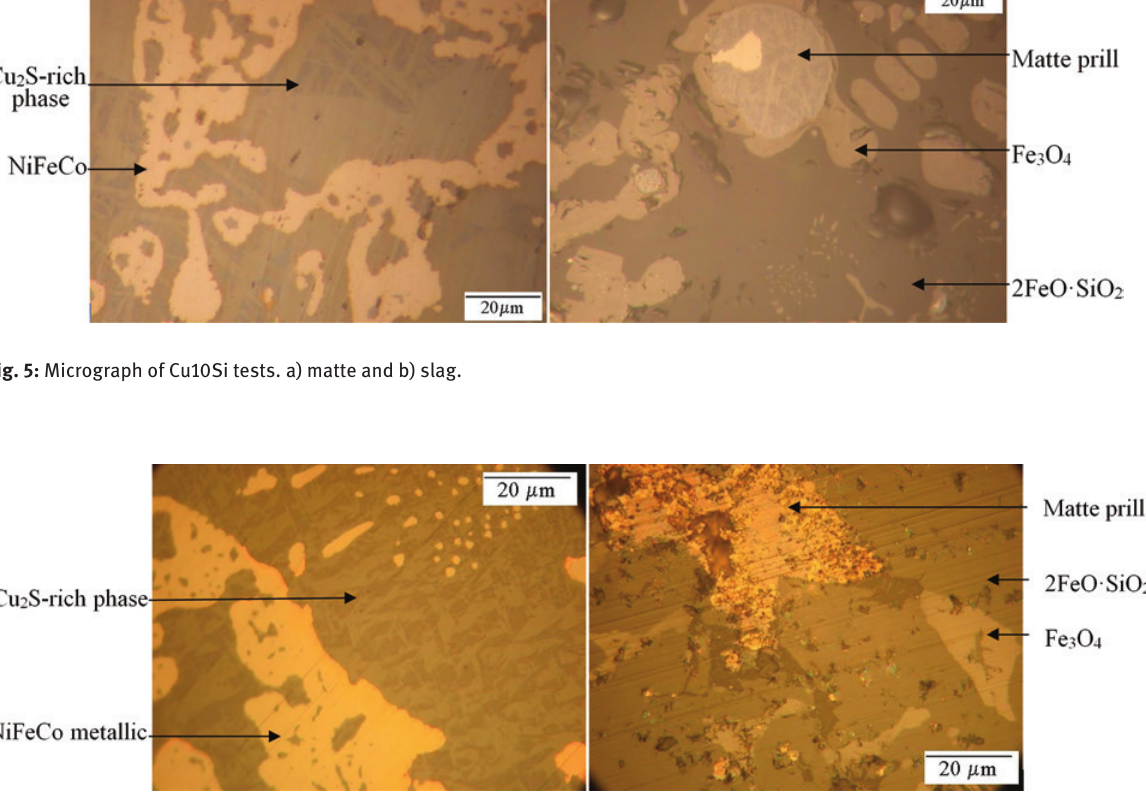
Fig. 6: Micrograph of Cu30Si tests. a) matte and b)